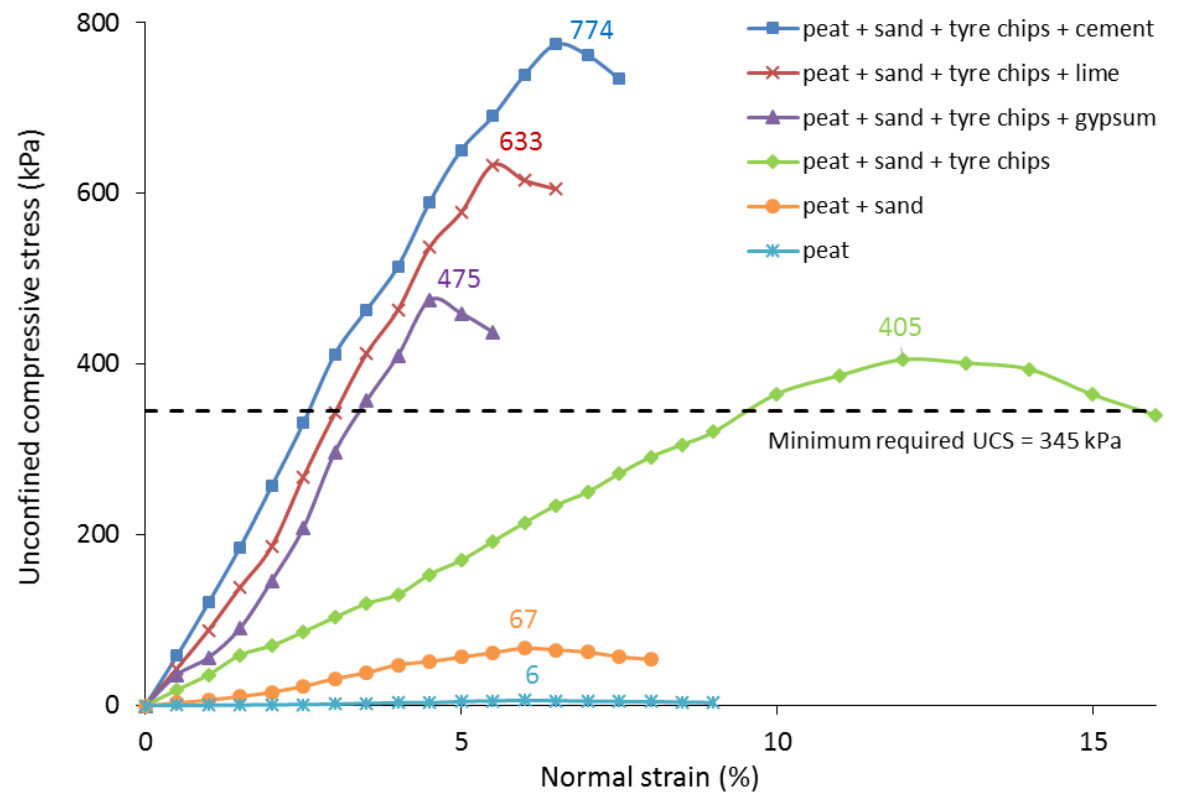
Figure 2. Variation of unconfined compressive strength (UCS) with normal strain in unconfined compression testing for untreated Chaghakhor peat, peat with 400 kg m -3 of sand and peat with sand and 10 % by weight of shredded tyre chips, from Rahgozar & Saberian (2015, 2016); and for peat with sand (400 kg m -3 ), tyre chips (10 %) and 15 % by weight of one of the three pozzolanic additives (gypsum, lime or ordinary Portland cement) after 28 days of curing. In each case, UCS is equal to stress (the label value) at the peak of the stress-strain curve. The minimum UCS requirement set by ASTM D4609 is also